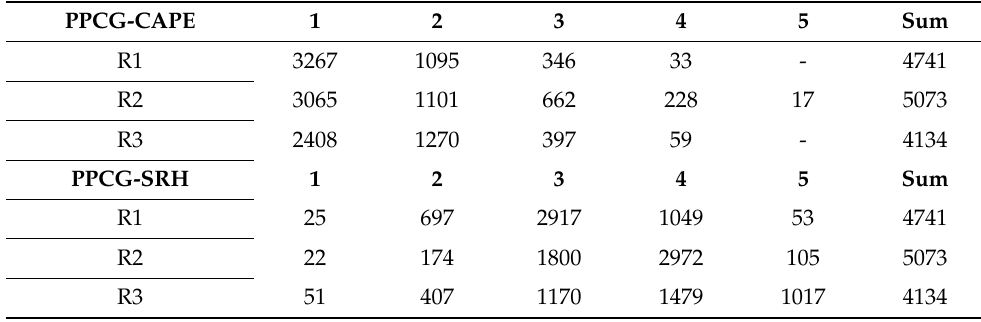
Table A3. The data number in each